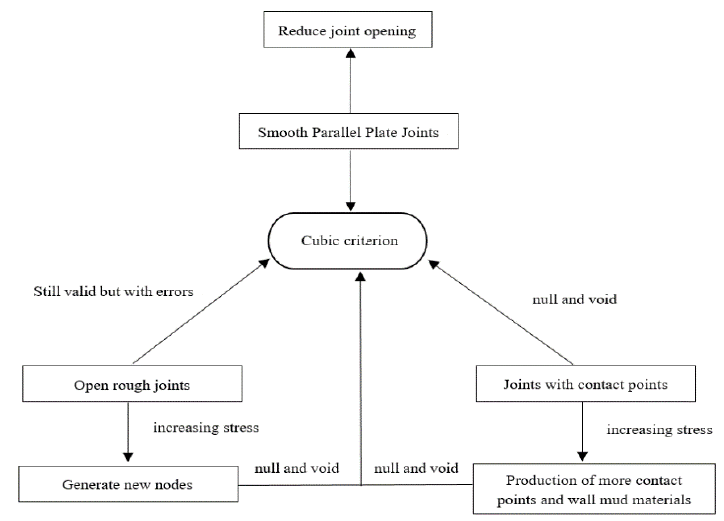
Figure 1. Validity of the cubic law for different fractured joints.